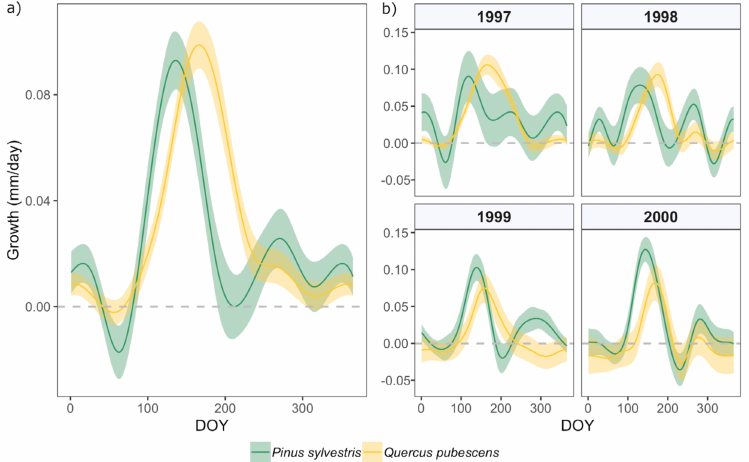
Figure 3. ( a ) Predicted radial growth rates of Scots pine and pubescent oak based on GAMMs for the period 1997–2000. ( b ) Predicted radial growth rates of Scots pine and pubescent oak based on GAMMs that include a smoothing function for day of year (DOY) that may vary as a function of each study year. Shaded area indicates the 95% confidence intervals of the model.